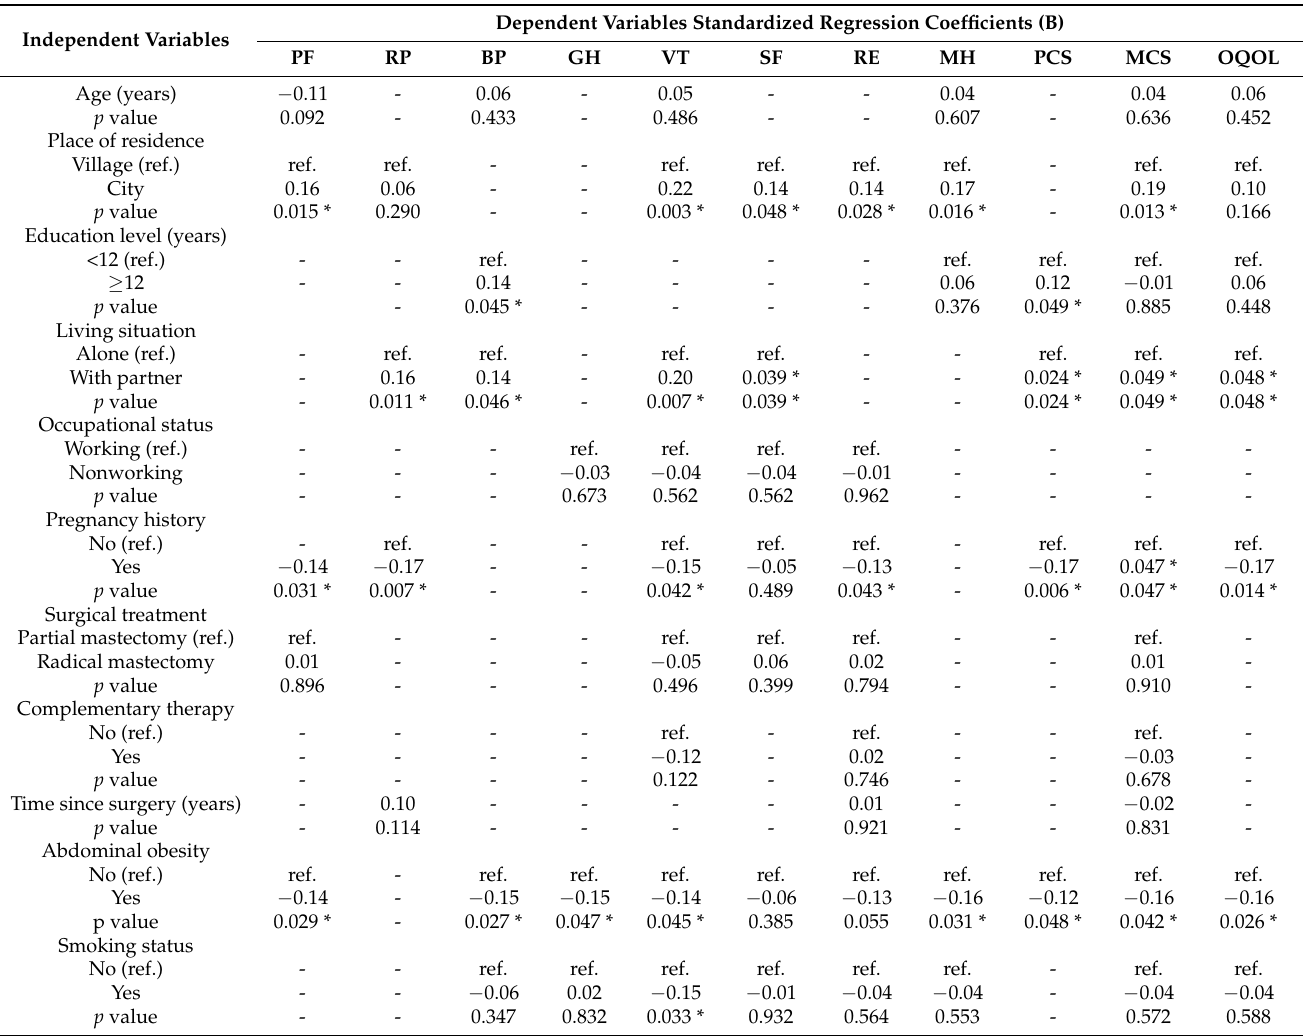
Table 4. Predictors of quality of life in breast cancer patients long after completed treatment ( n = 250). Independent